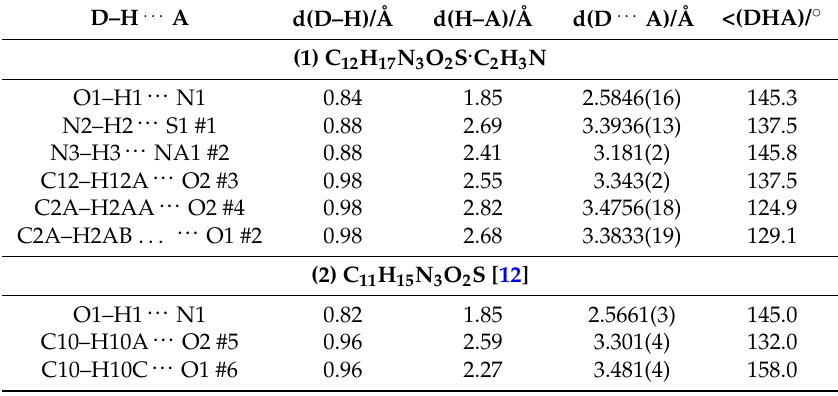
Table 4. Hydrogen bond interactions for ( 3 ) and ( 4 ) [Å and °].